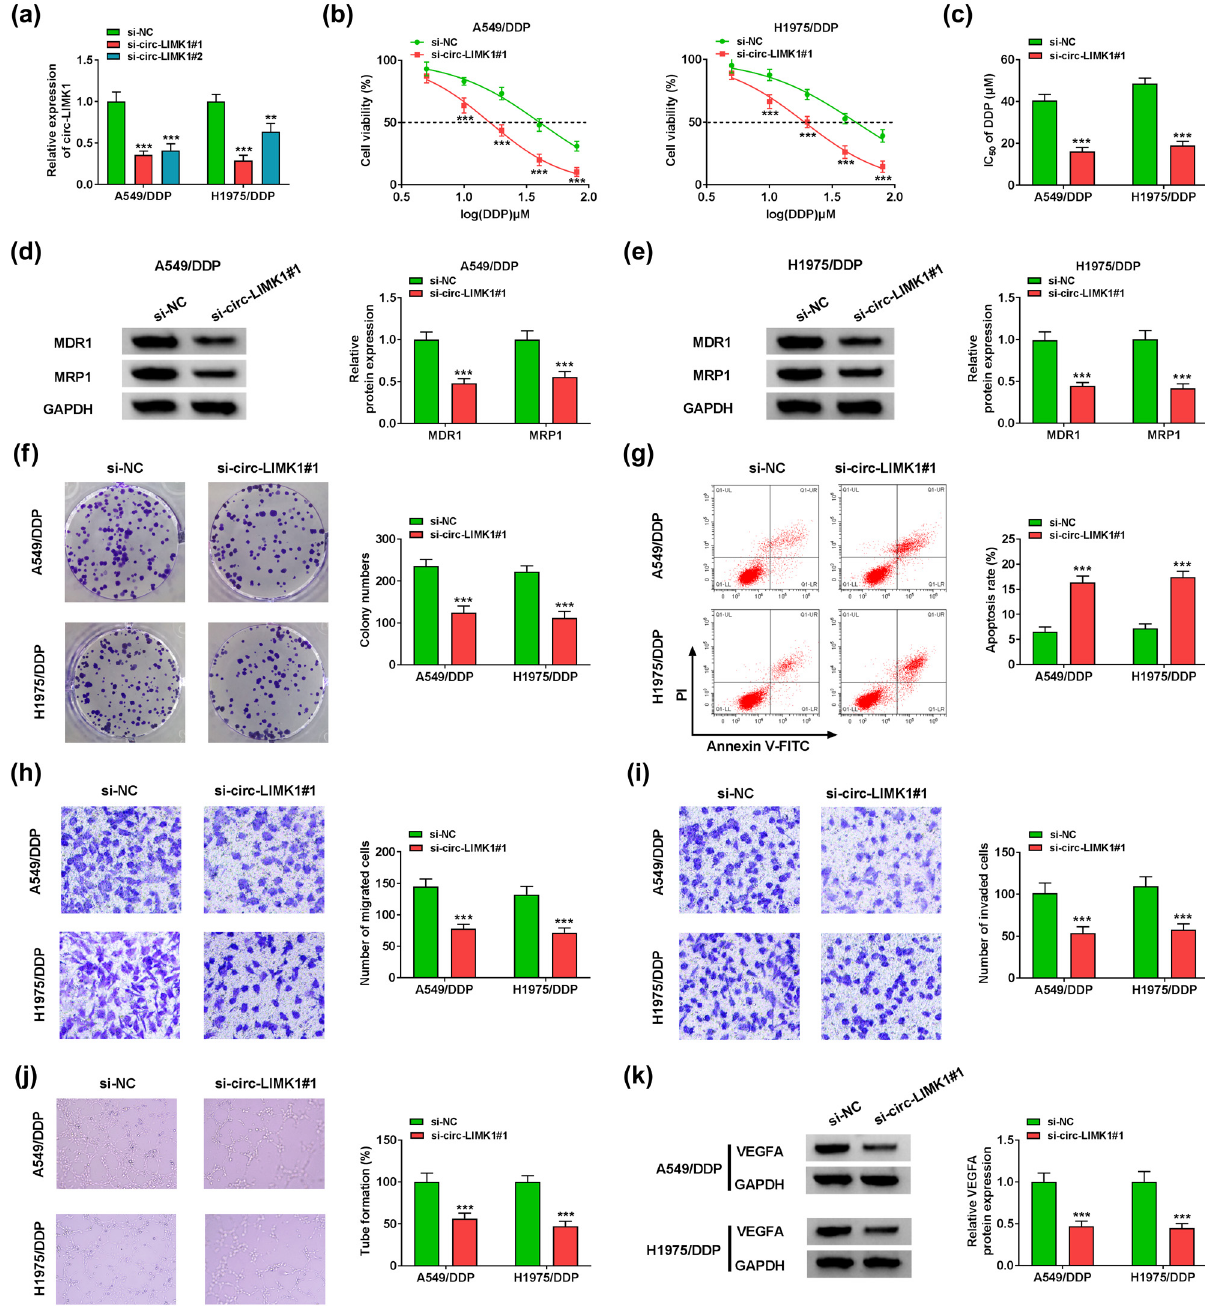
Figure 2: Knockdown circ - LIMK1 could in fl uence cell proliferation, migration, invasion, DDP resistance, tube formation, and apoptosis in lung adenocarcinoma DDP - resistant cells. ( a ) RT - qPCR was applied to examine the expression of circ - LIMK1 in A549/DDP and H1975/DDP cells after transfected with si - NC, si - circ - LIMK1#1, and si - circ - LIMK1#2. A549/DDP and H1975/DDP cells were transfected with si - NC or si - circ - LIMK1#1. ( b ) MTT assay was used to analyze cell viability. ( c ) MTT assay was applied to detect IC 50 value. ( d and e ) Western blot was used to measure the protein levels of MDR1 and MRP1. ( f ) Colony formation assay was employed to analyze the number of colonies. ( g ) Flow cytometry was applied to detect cell apoptosis. ( h and i ) Transwell assay was employed to test cell migration and invasion. ( j ) Tube formation assay was used to analyze the tube formation. ( k ) Western blot was adopted to measure the expression of VEGFA. *P < 0.05, ** P < 0.01, *** P <